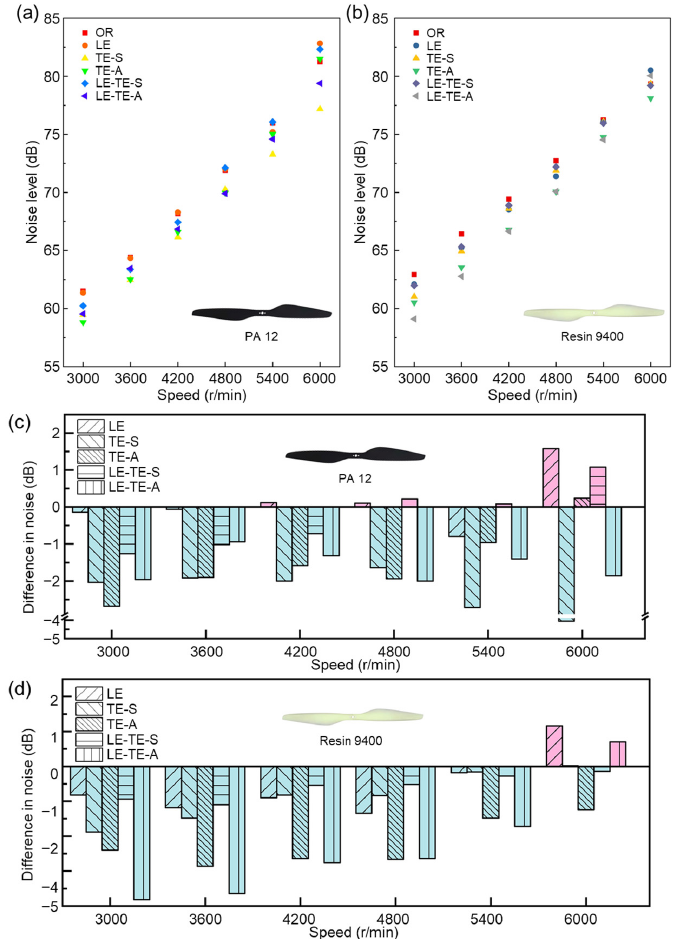
Figure 12. Comparison of noise level of different rotors. ( a ) Noise level of bionic rotors with PA 12; ( b ) Noise level of bionic rotors with Resin 9400; ( c ) Comparison of noise level between bionic rotors with PA 12; ( d ) Comparison of noise level between bionic rotors with Resin 9400. The noise level of the OR rotor was taken as a reference value (0 dB). Under the same conditions, the increase in noise level was positive and the decrease in noise level was